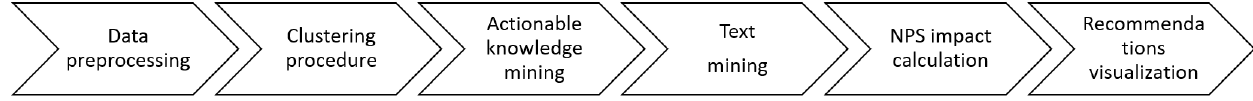
Figure 1. The original procedure for generating data-driven recommendations for customer loyalty improvement based on quantitative and qualitative customer